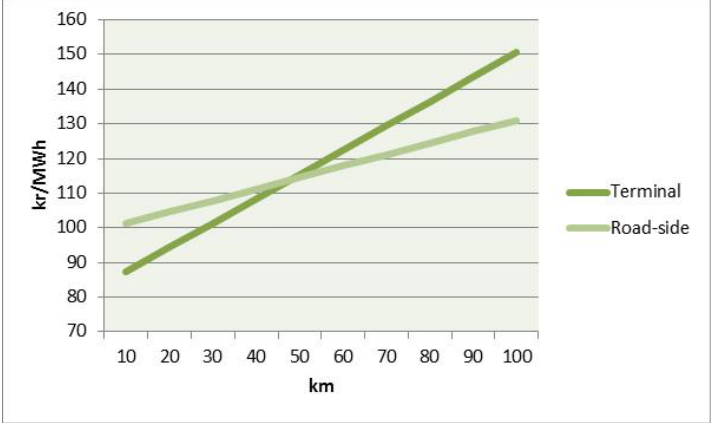
Figure 8. Break-even point between road-side chipping and terminal